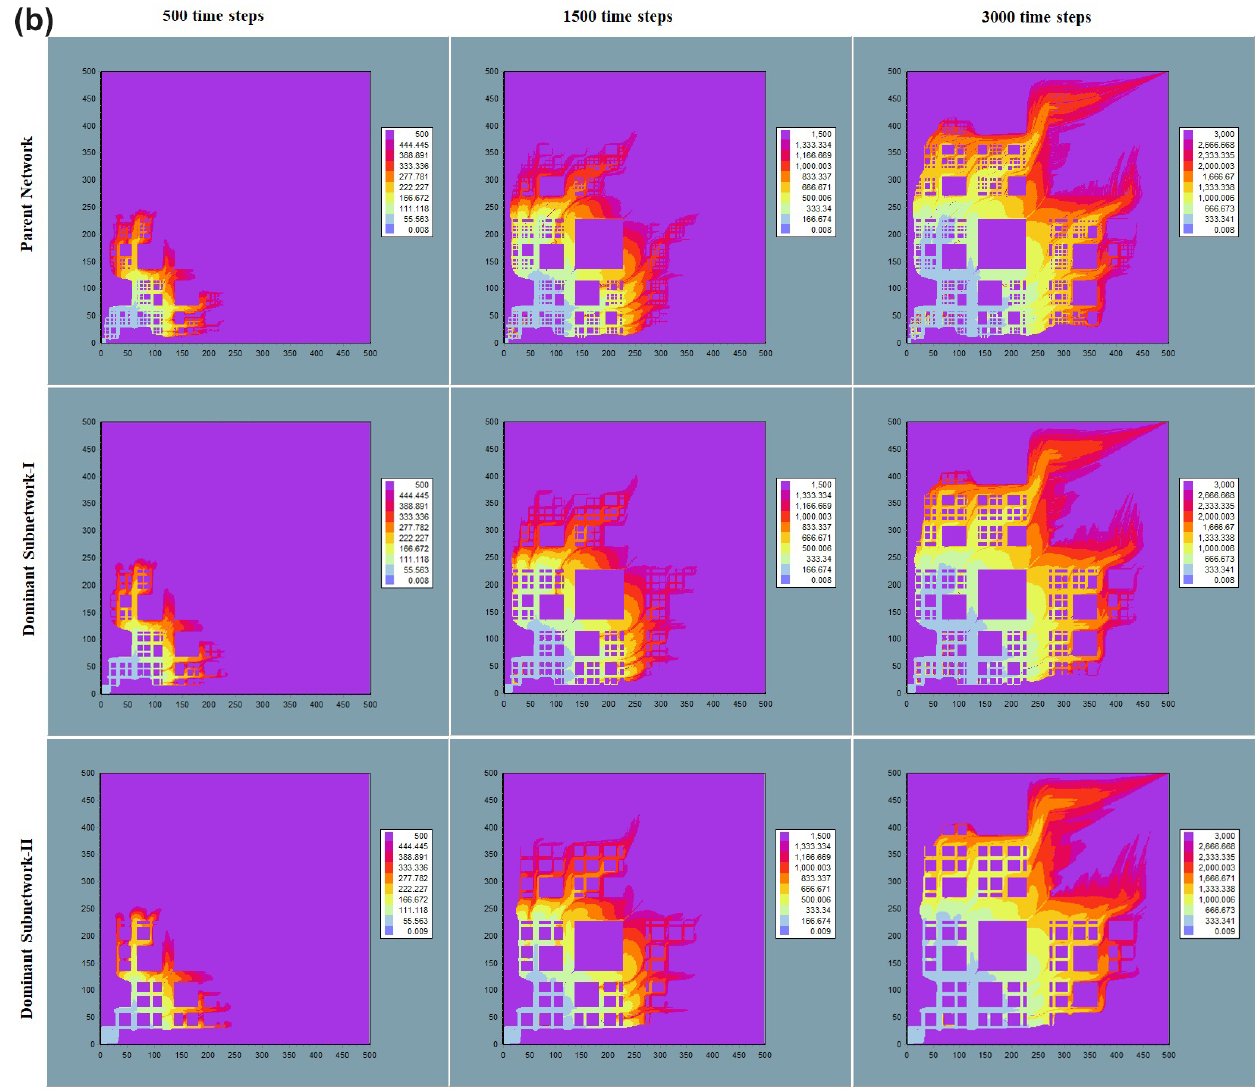
Figure 6. (a) TOFs at different time periods of deterministic fractal-fracture network (top), its dominant sub-network-I (centre) and -II (bottom). (b) TOFs at different time periods of random fractal-fracture network (top), its dominant sub-network-I (centre) and -II